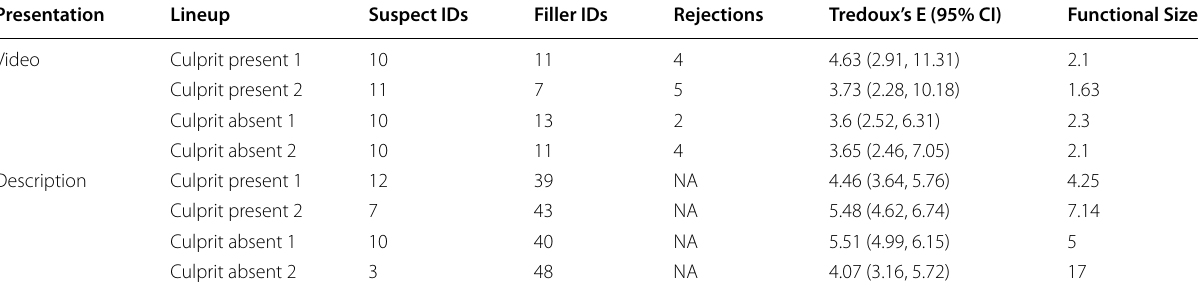
For culprit present lineups, suspect IDs are correct. For culprit absent lineups, rejections are correct